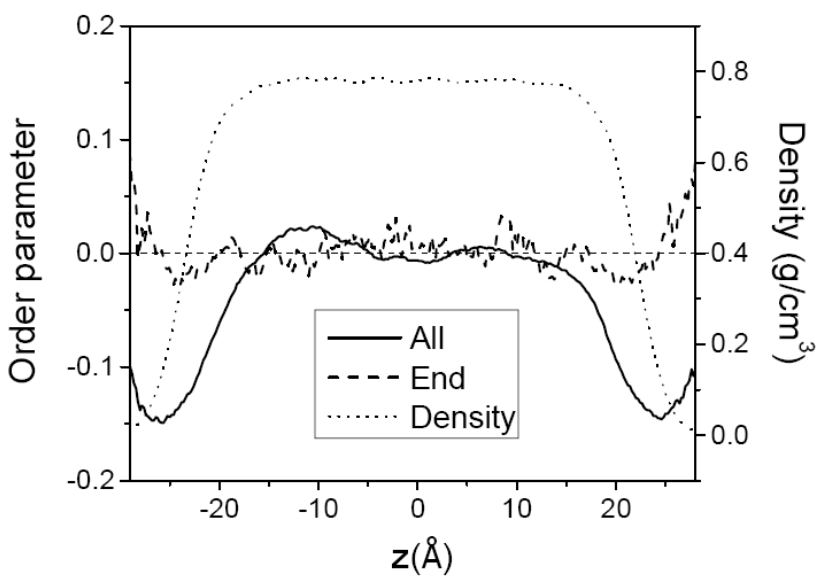
Figure 6. The order parameter of C 150 H 302 melt film at 400 K along the film thickness direction ( z ) with the film center at z = 0. The solid line is for all segment vectors, and the dashed line is for the endmost vectors. The overall density profile of the film is shown by the dotted line.